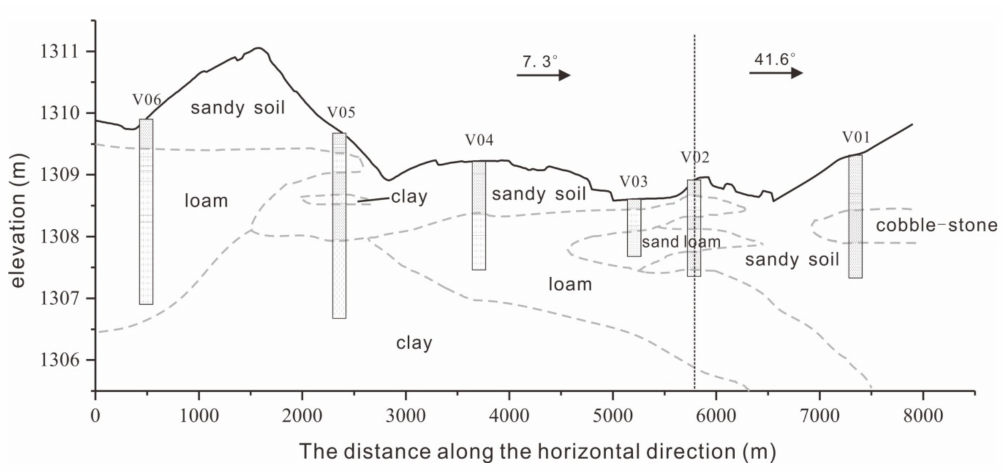
Figure 2. Simplified geological cross section from V01 to V06 (locations are shown in Figure